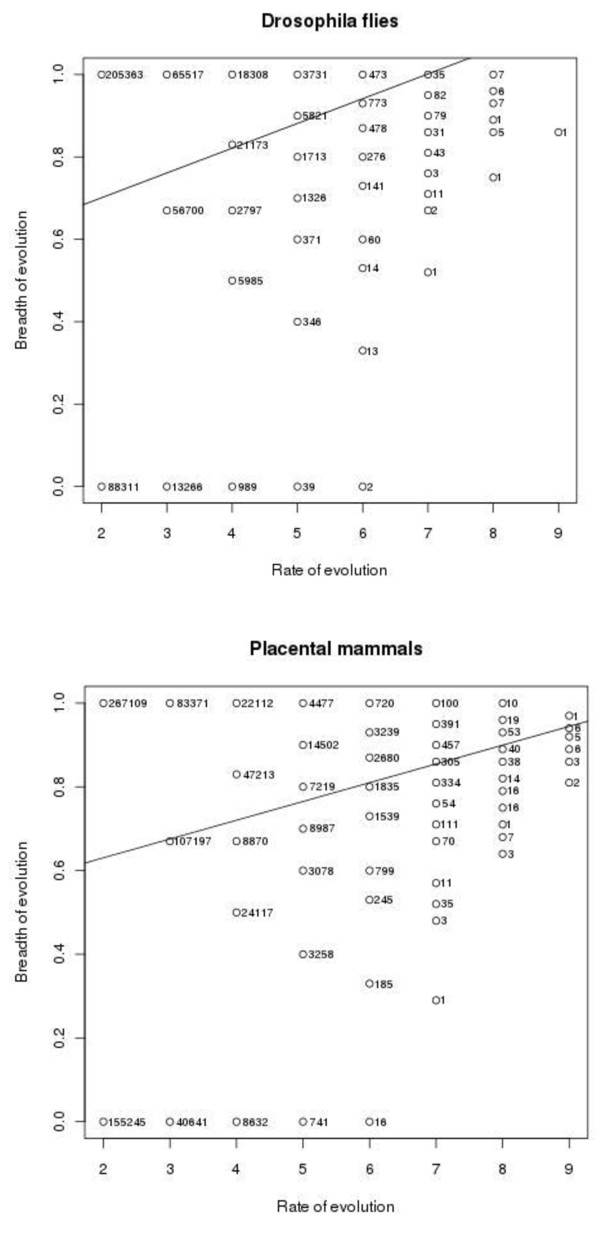
Numbers of sites with different combinations of values of n and B in Drosophila flies (left) and placental mammals (right).